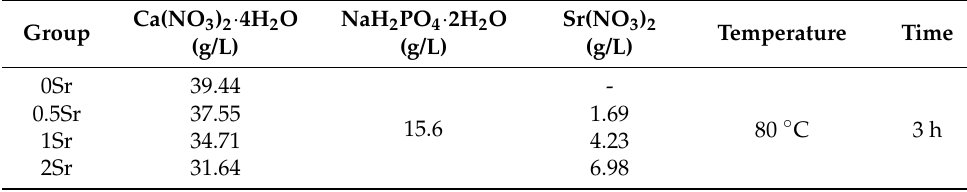
Table 1. Detailed conditions for surface